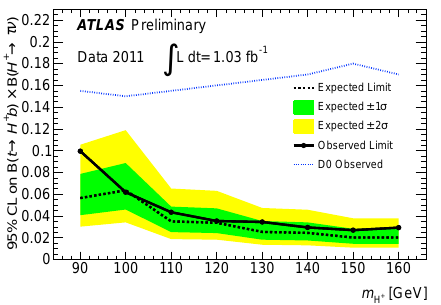
Fig. 2. m T distribution after event selection.